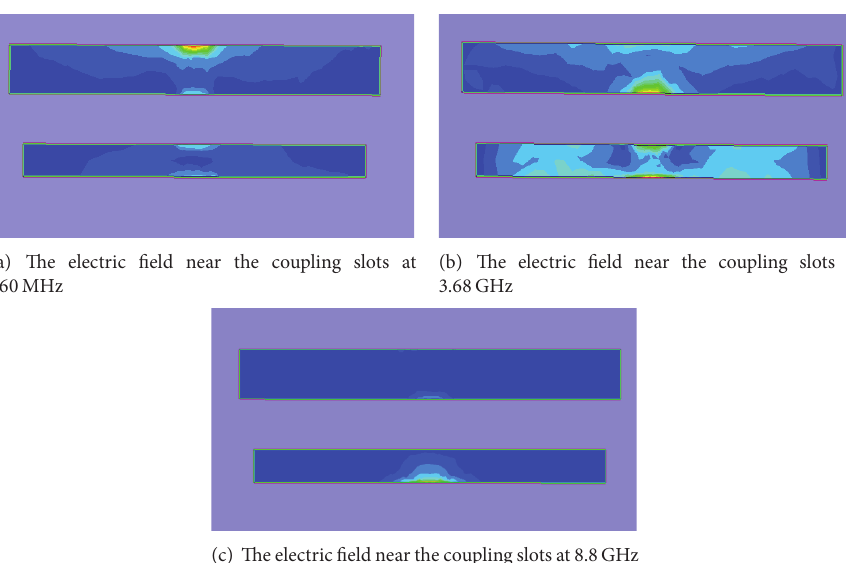
Figure 5: The magnitude of the electric field near the two slots. (a) The electric field near the coupling slots at 0.98 GHz. (b) The electric field near the coupling slots at 3.64 GHz. (c) The electric field near the coupling slots at 8.38 GHz.